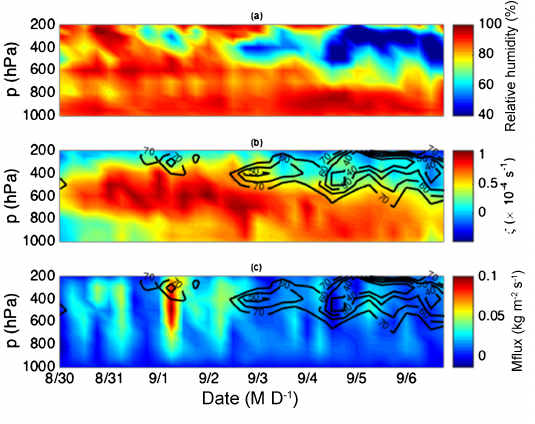
Figure 4. Time-height cross-section of system-averaged quantities within a 3 ◦ × 3 ◦ box from 00:00UTC 30 August to 18:00UTC 6 September. Relativity humidity is shown in (a) , relative vorticity ( ζ ) with relative humidity contours of 40, 50, 60, and 70% is shown in (b) , and mass flux with relative humidity contours of 40, 50, 60, and 70% is shown in (c) . A dry layer near and above 600hPa ap- pears on 2 September and persists through 6 September. There are corresponding decreases in relative vorticity and mass flux at these times.